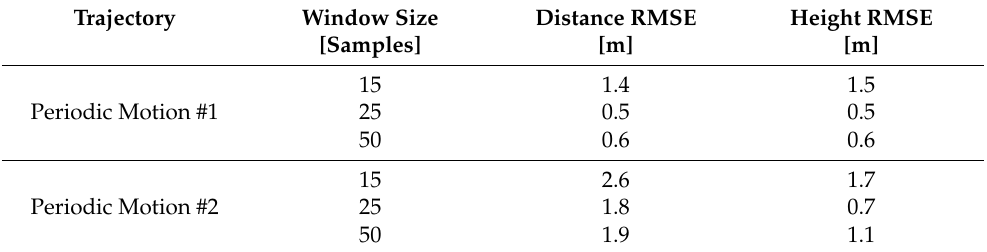
Table 5. Influence of window size on QuadNet1 performance using IMU #1 measurements.